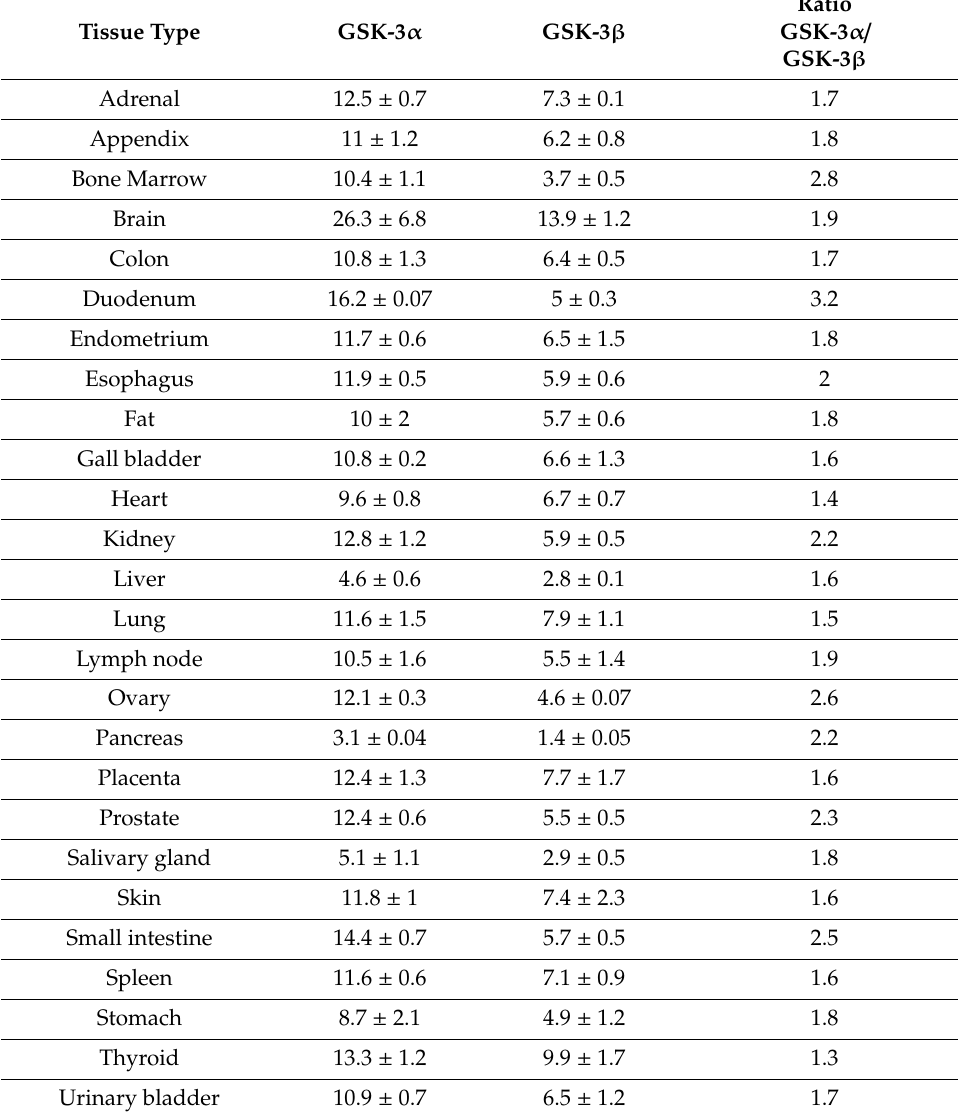
Table 1. GSK-3 α and GSK-3 β Expression in Di ff erent Human Tissue Types.